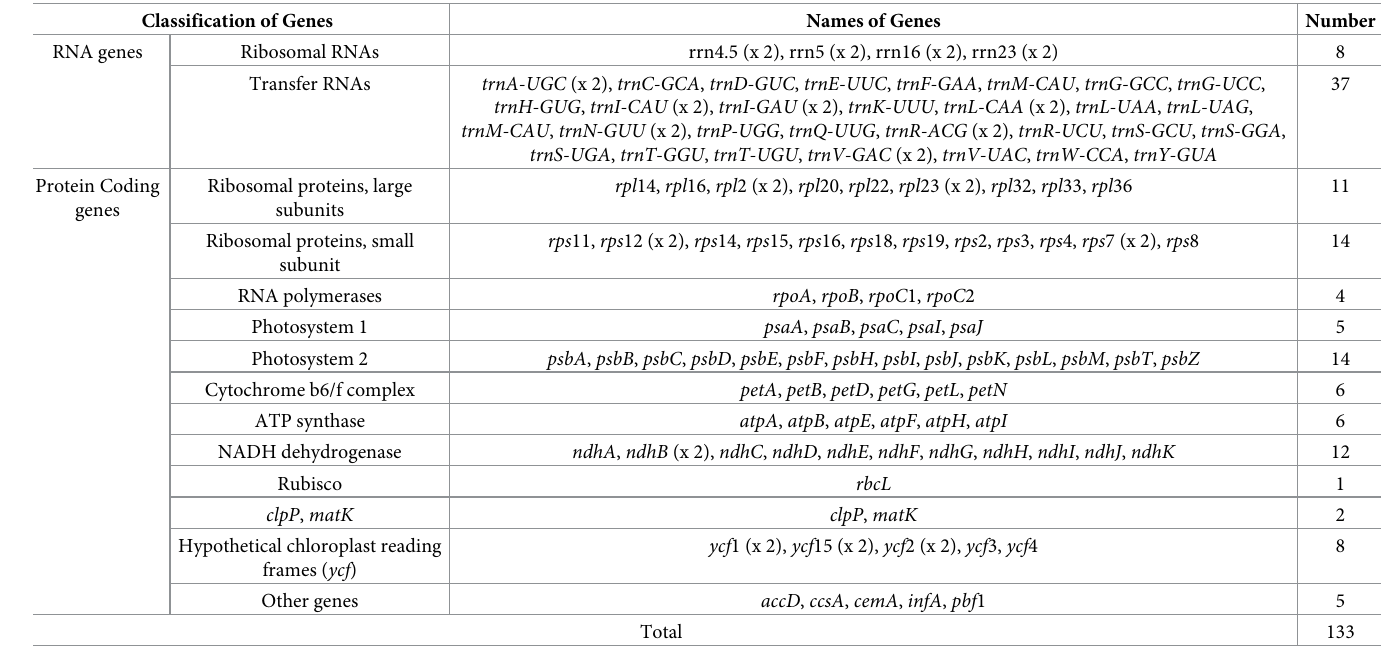
Table 1. List of annotated genes in the C . nipponicum chloroplast genome. Classification of Genes Names of Genes Number RNA genes